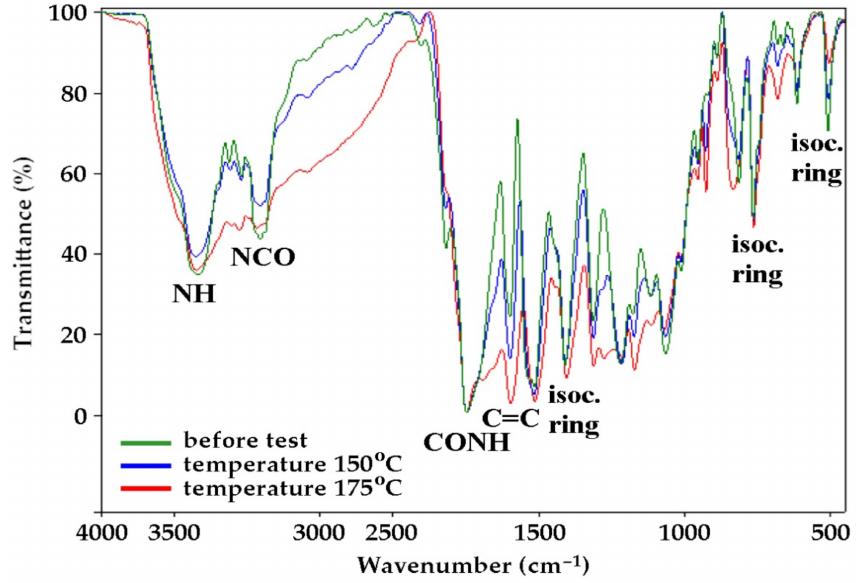
Figure 6. FTIR spectra of foam obtained from a mixture of polyols based on PLA and MSA before and after thermostating at the temperature of 150 ◦ C and 175 ◦